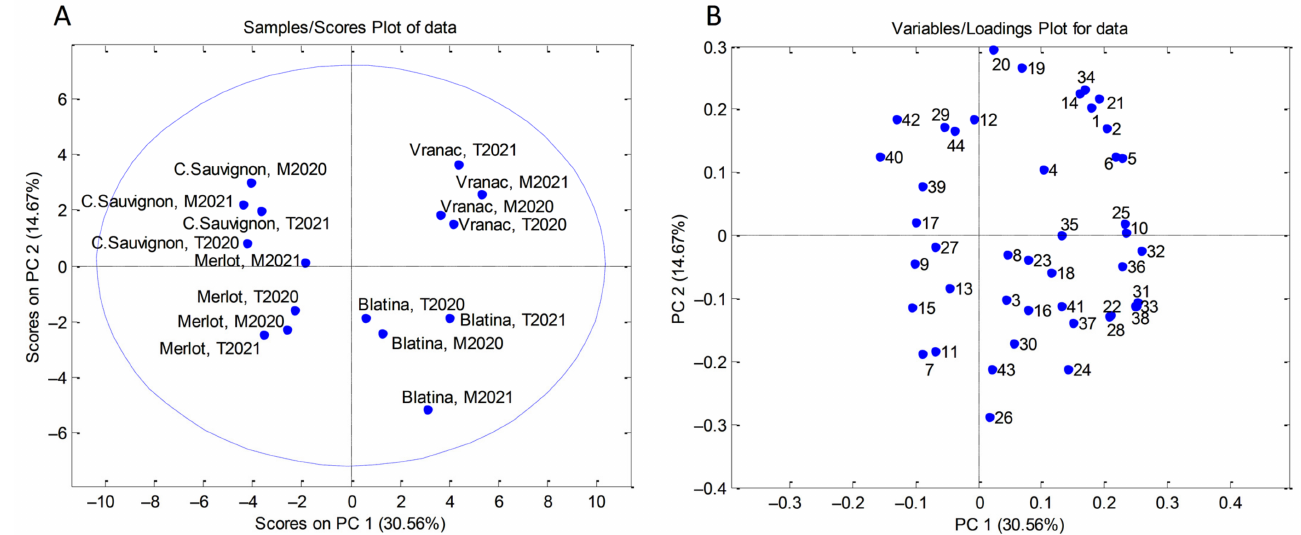
Figure 4. PCA analysis performed on data obtained from phenolic profiles (individual polyphenols, TPC, and RSA) and physicochemical parameters of grape samples: ( A ) score plot and ( B ) loading plot (number of compounds corresponds to Table 7 and Table